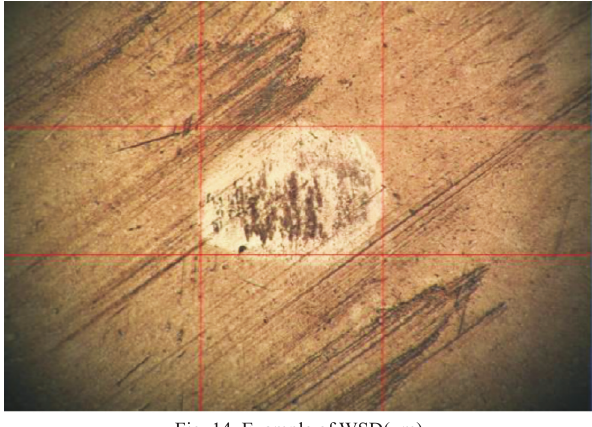
Fig. 14. Example of WSD(μm)